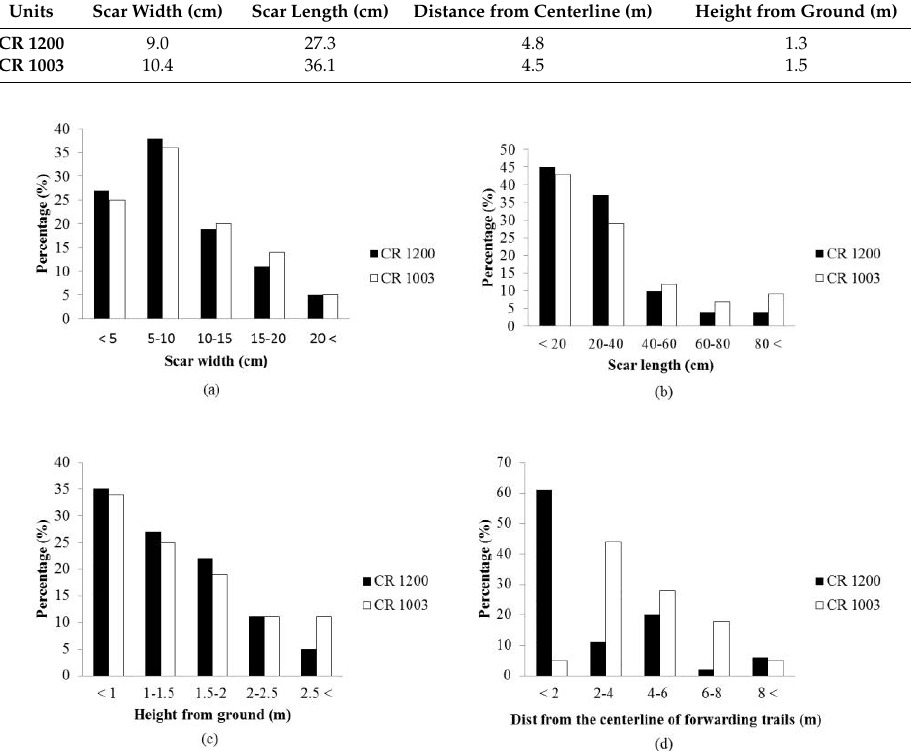
Table 5. Summary of scar characteristics from CTL thing for each unit.